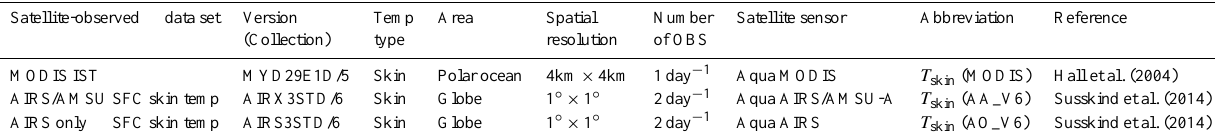
Table 1. The information on the satellite-observed surface skin temperature ( T skin ) Level 3 (L3) data used in this study. Three data sets of T skin were compared over the Northern Hemisphere during 16–24 April 2003–2014, and over the Southern Hemisphere during 15– 23 September 2003–2014. The abbreviations used in this table are as follows: temp (temperature), IST (ice surface skin temperature), OBS (observation), and SFC